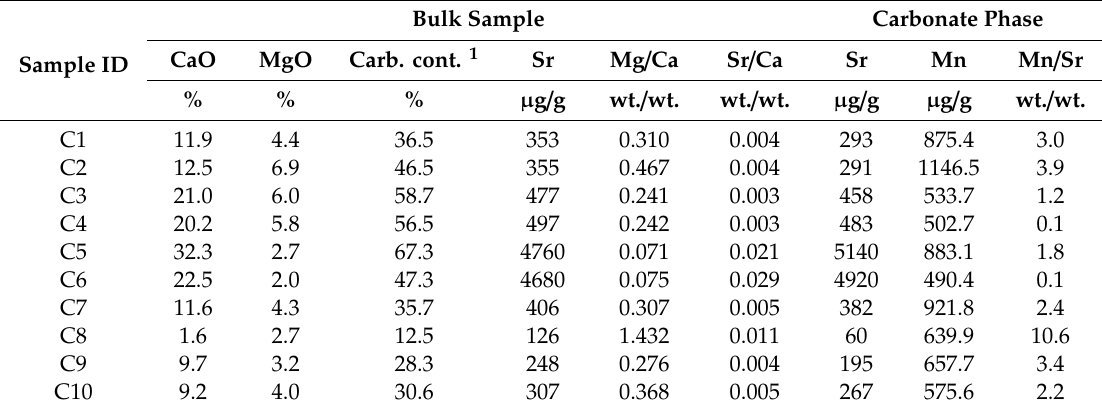
Table 1. Selected elemental contents of carbonate phases and bulk rocks.